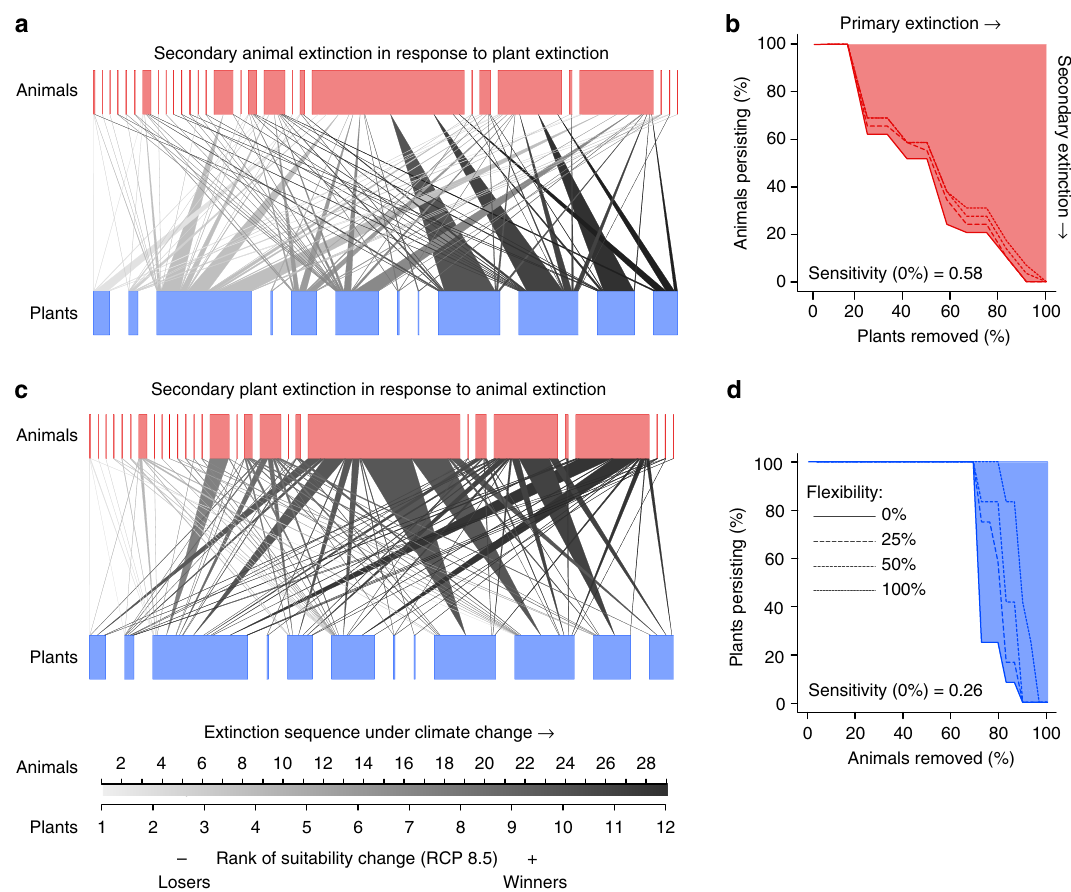
Figure 2 | Secondary animal and plant extinction under climate change. Shown are ( a , b ) secondary animal extinction in response to plant extinction and ( c , d ) secondary plant extinction in response to animal extinction for a seed-dispersal network from Białowiez˙a forest (network ID ¼ S1; 12 plant and 29 bird species). ( a , c ) Species (rectangles in red (animals) and blue (plants), connected by weighted interaction links; box and line width correspond to interaction frequencies) are removed sequentially according to projected suitability changes in climatic conditions. Low ranks (light shade) correspond to a high vulnerability to climate change, high ranks (dark shade) correspond to a low vulnerability; thus, light links are prone to extinction, whereas dark links are the persisting backbone of interactions under climate change. The corresponding secondary extinction plots ( b ) for animals (red) and ( d ) plants (blue) show network sensitivity to species extinction (filled area above the extinction curve) under four scenarios of species’ flexibility (solid to dotted lines) to reallocate interactions to persisting partners (constrained rewiring); here secondary extinction is triggered after 50% interaction loss. In this network, sensitivity to plant extinction (red area) was larger than sensitivity to animal extinction (blue area), that is, animal species went more quickly secondarily extinct than plant species. Secondary extinction plots for the 12 other interaction networks are shown in Supplementary Fig.